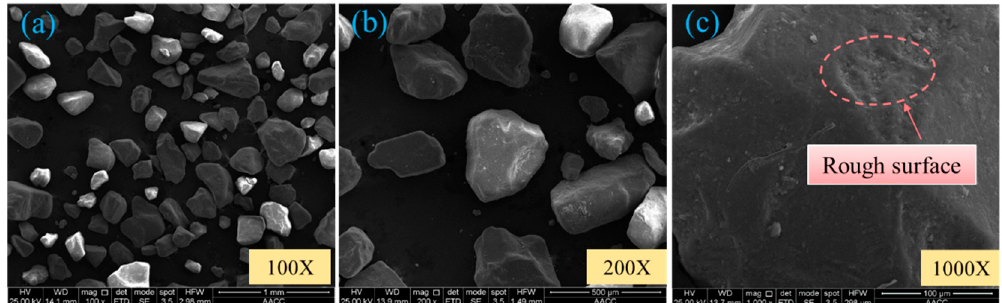
Figure 1. Scanning electron microscopy (SEM) micrographs of AS. Magnification levels are shown in the bottom right-hand corners: ( a ) AS at 100x magnification ; ( b ) AS at 200x magnification ; ( c ) AS at 1000x magnification .